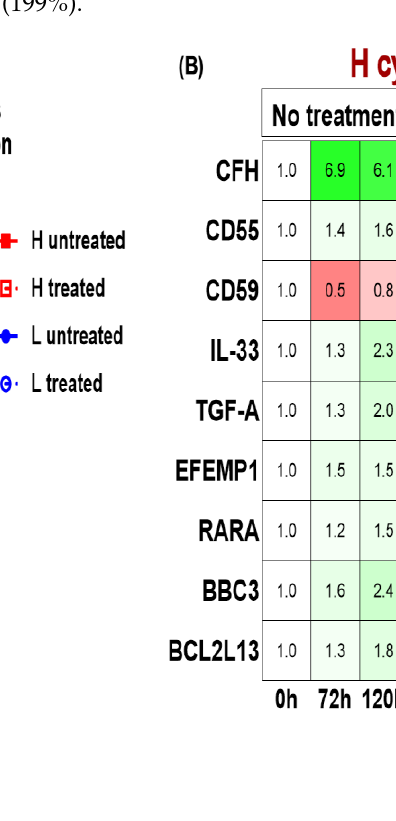
Figure 2. Evaluating the H (European) and L (African) hybrids’ responses to UV radiation treat- ment. ( A ) In both UV-treated and untreated groups, hybrids having L haplogroup mtDNA had a steeper growth curve slope than H haplogroup mtDNA. Untreated, both H and L cybrids showed consistent increases in growth patterns. Growth rates in UV-treated samples slowed or declined until about 96 h after treatment, then increased again. The trypan blue assay was performed with technical and biological replicates, and each experiment was repeated twice. The red solid line represents untreated H cybrids; the red broken line represents UV-treated H cybrids; the blue solid line represents untreated L cybrids; and the blue broken line represents UV-treated L cybrids. ( B ) Analysis of the differential expression of CFH, CD55, CD59, IL-33, TGF-A, EFEMP1, RARA, BBC3, and BCL2L13 in H and L cybrids exposed to UV light for 0, 72, and 120 h with and without treatment. Heatmap representation of CFH, CD55 , CD59 , IL-33 , TGF-A , EFEMP1 , RARA , BBC3 , and BCL2L13 differential expression. The numbers in the heatmap show the average relative fold-change values.